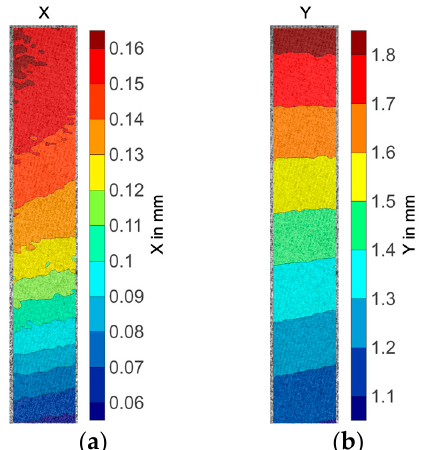
Figure 10. Representative DIC displacement and strain fields of 75° off-axis tension specimen: ( a ) X direction displacement fields; ( b ) Y direction displacement fields; ( c ) X direction strain fields; ( d ) Y direction strain fields.